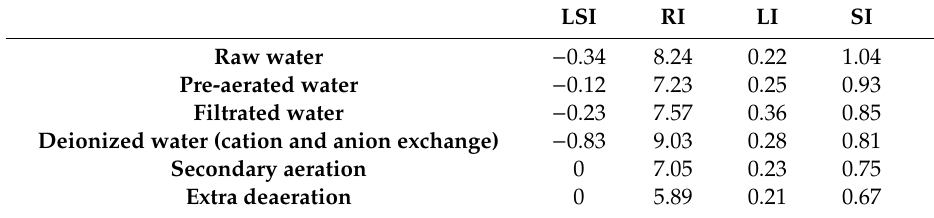
Table 2. Aggressiveness and corrosion indicators of raw water and treated industrial water. LSI RI SI Raw water − 0.34